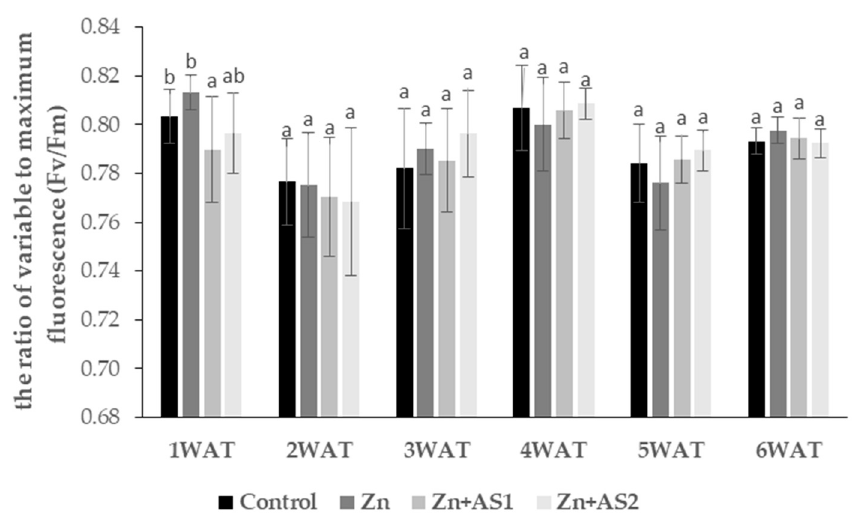
Figure 5. The effect of different foliar treatments (Zn, Zn+AS1, and Zn+AS2) on the ratio of variable to maximum photochemical efficiency of PSII in the second youngest and fully developed leaves of maize 1, 2, 3, 4, 5, and 6 WAT. n = 20 ± S.D. Lower case letters (a, b) show the significant differences among the treatment based on sampling time. WAT: week(s) after treatment; PS: photosystem. The proline content in leaves was significantly increased when zinc-containing foliar fertilizer (Zn) was used in combination with amino acid-containing (AS1 and AS2) foliar fertilizers one and two WAT relative to the control. Additionally, the Zn+AS2 treatment also affected proline three WAT. None of the treatments showed efficacy from 4 WAT (Figure 6).